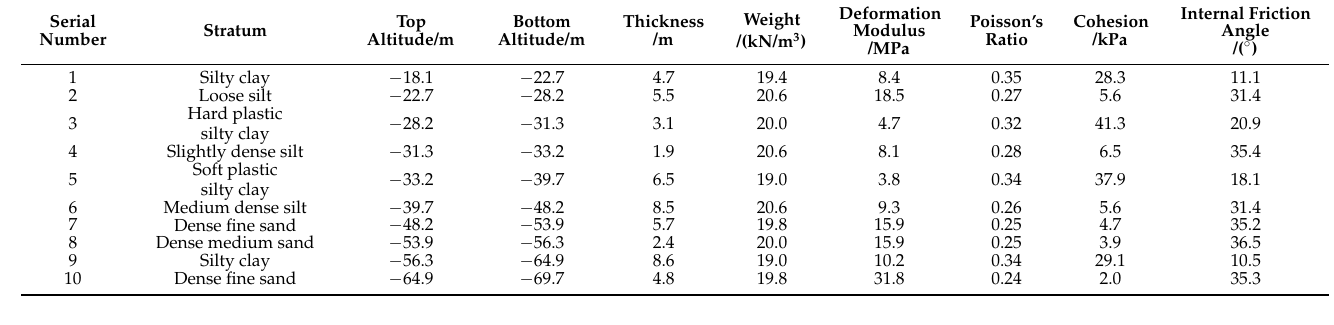
Table 1. Stratum and soil parameters.